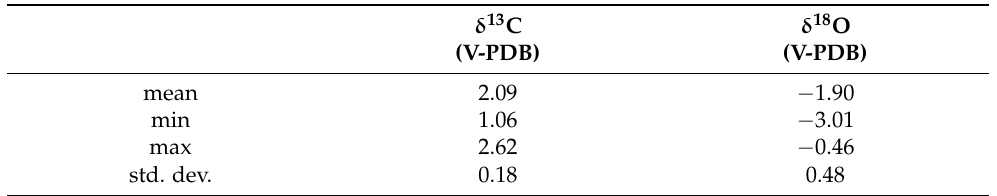
Table A1. Mean, standard deviation and minimum/maximum values of the Carrara marble reference isotope database (‰ vs.